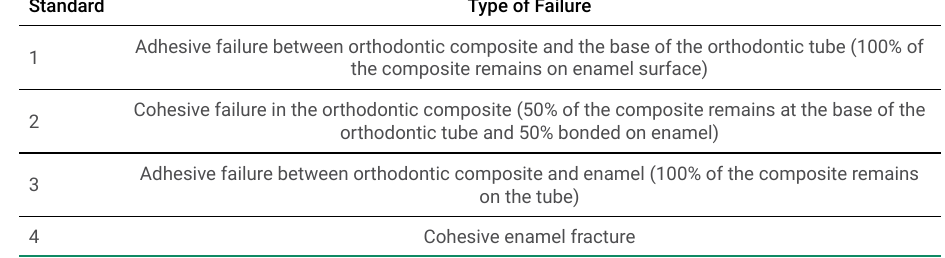
Table 2. Failure mode classification